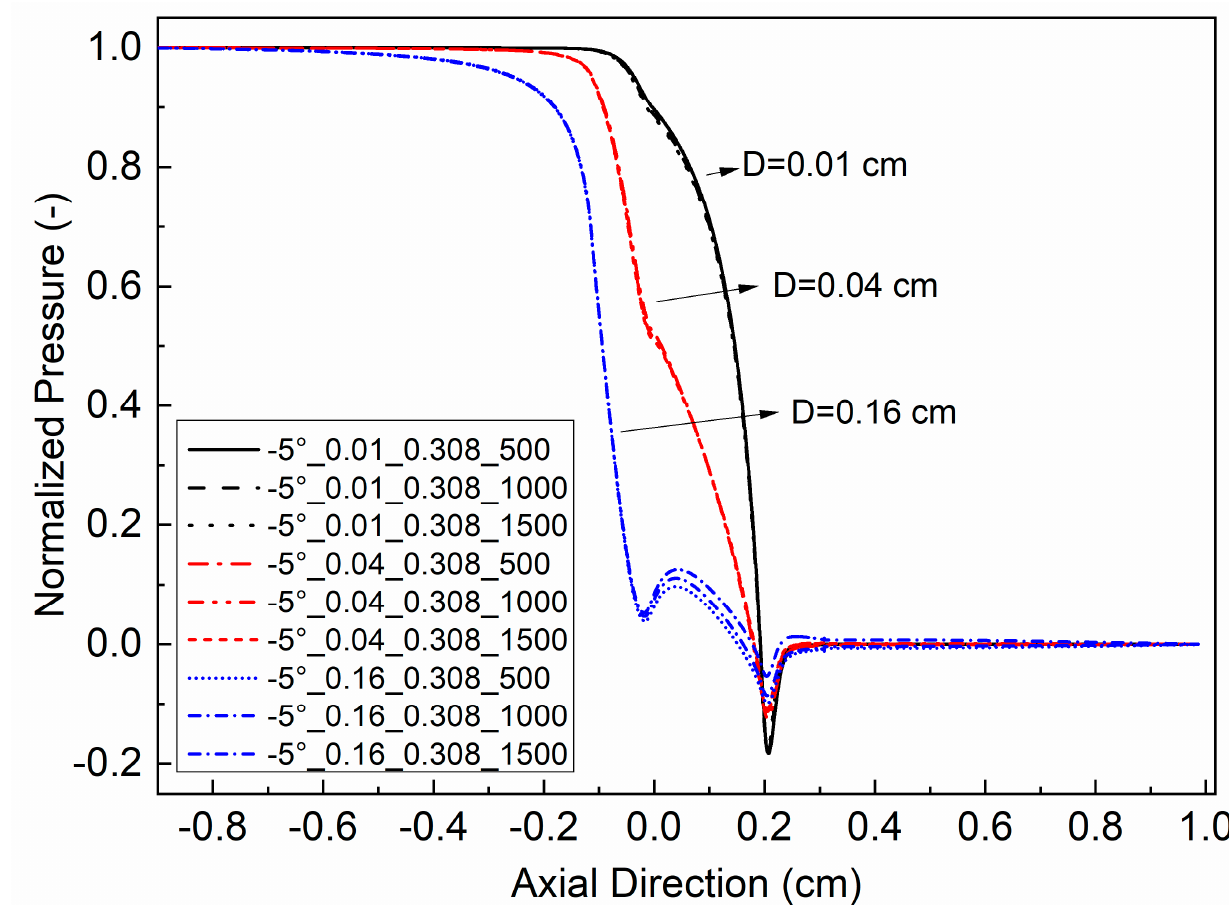
Figure 3. (Color online) Non-dimensional intraglottal pressure distributions for − 5 ◦ convergent glottal angle and 0.308 glot- tal duct length for three minimal diameters (0.01, 0.04, and 0.16 cm) and three transglottal pressures (500 Pa, 1000 Pa, and 1500